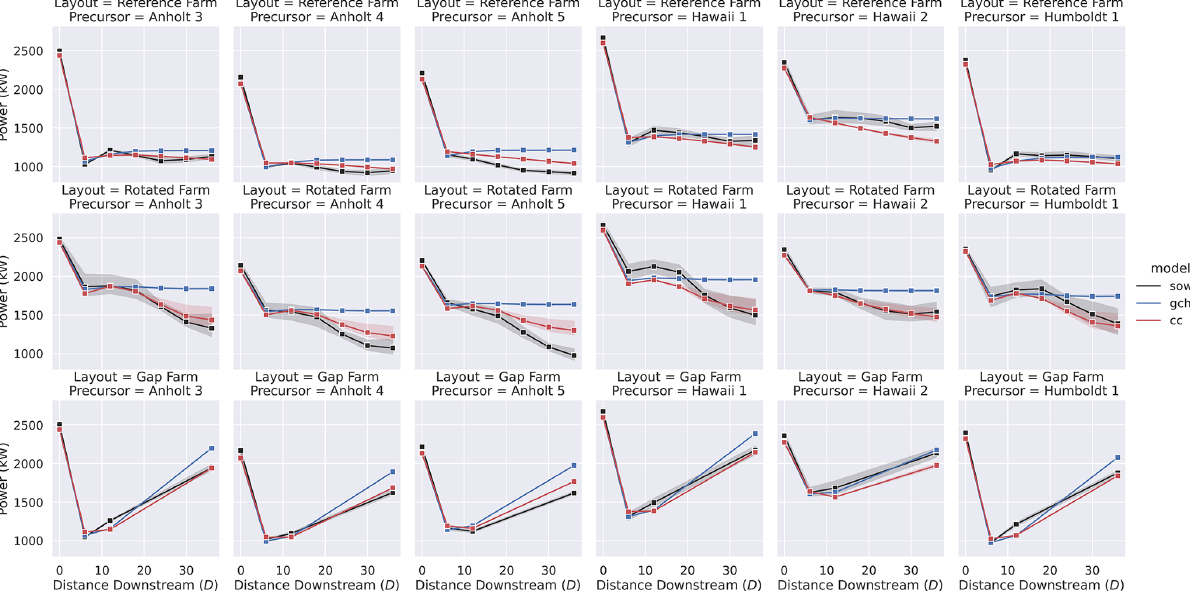
Figure 5. Comparing the power produced by row across farm types and models. Note that the plot points are average power for a row (with the shaded band indicating confidence interval) and the x axis is the row’s distance downstream from front turbines, in D . Each row of the plot is a farm type, while each column is a